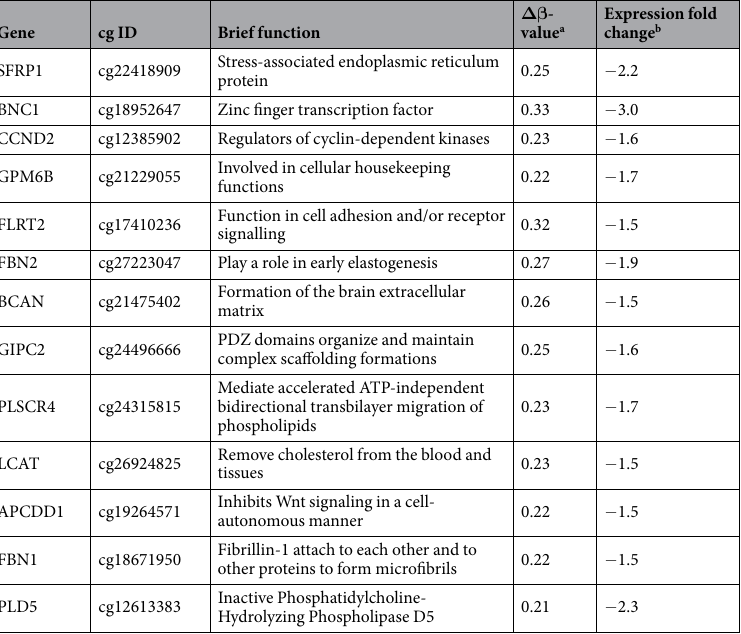
Table 1. Selected genes that show hypermethylation and downregulation in breast cancer cells. a The values are obtained by subtracting the methylation level in normal cells from that in cancer cells. b The values are obtained by dividing the expression level in cancer cells by that in normal